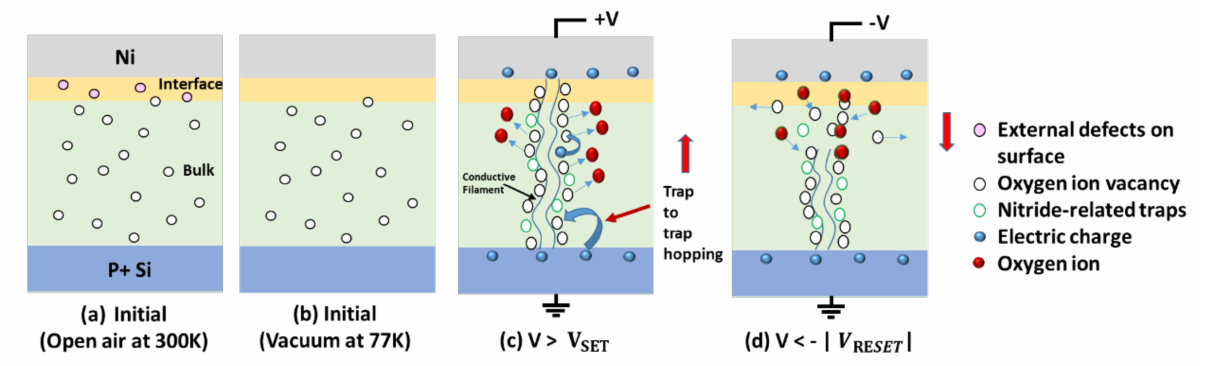
Figure 5. Schematics of proposed switching mechanism of Au/Ni/SiO x N y /p + -Si memory device in a vacuum at 77